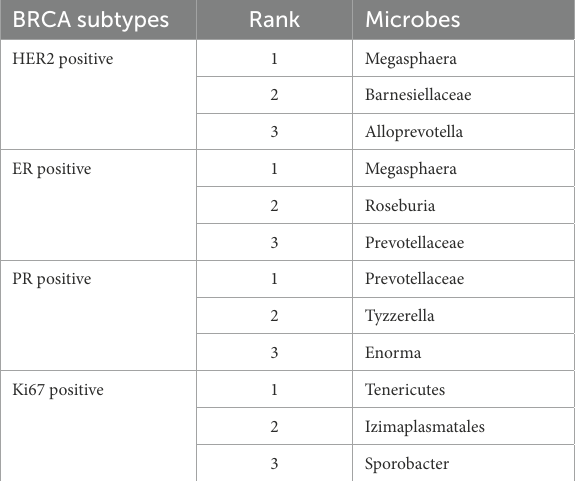
TABLE 4 Top 12 potential microbes related to breast cancer. BRCA